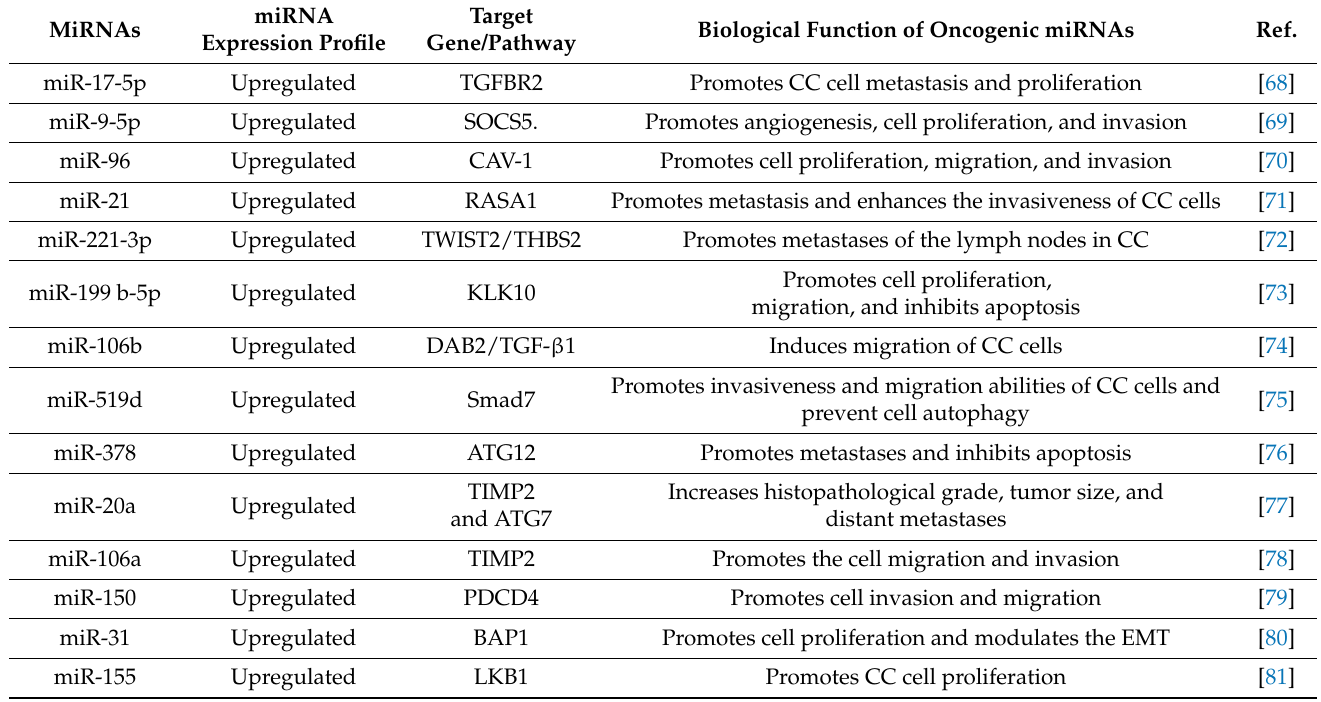
Table 1. Summary of selected oncogenic miRNAs with their functional effects in